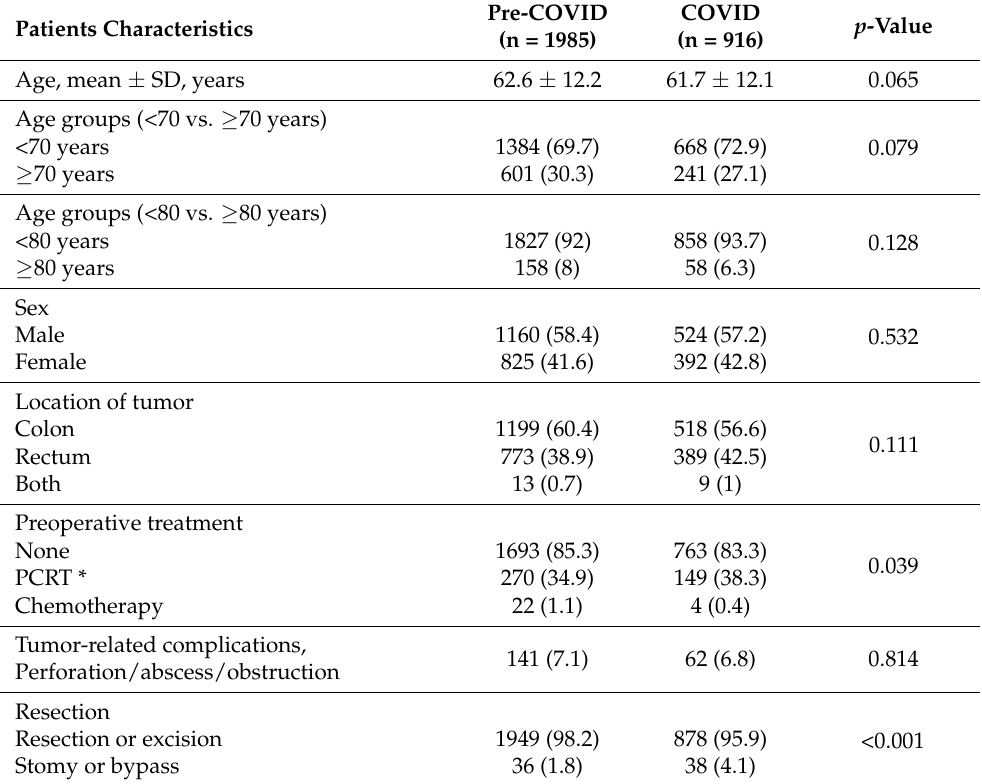
Table 1. Demographic and clinical characteristics and operative outcomes in colorectal cancer patients treated during the pre-COVID and COVID